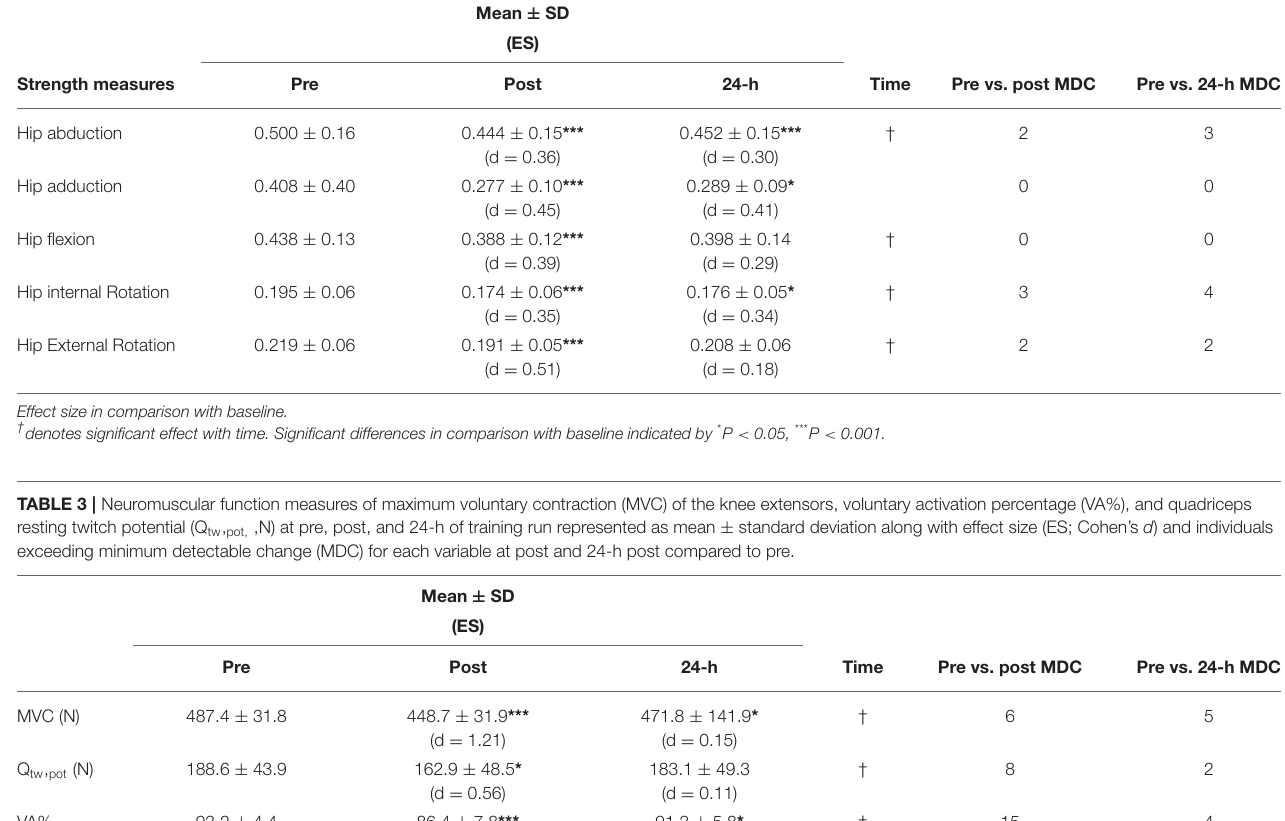
standard deviation for pre, post, and 24-h training run along with effect size ±